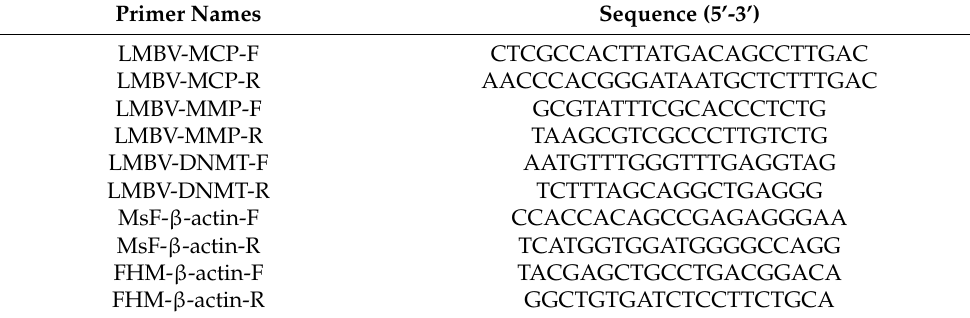
Table 1. The primers used in this